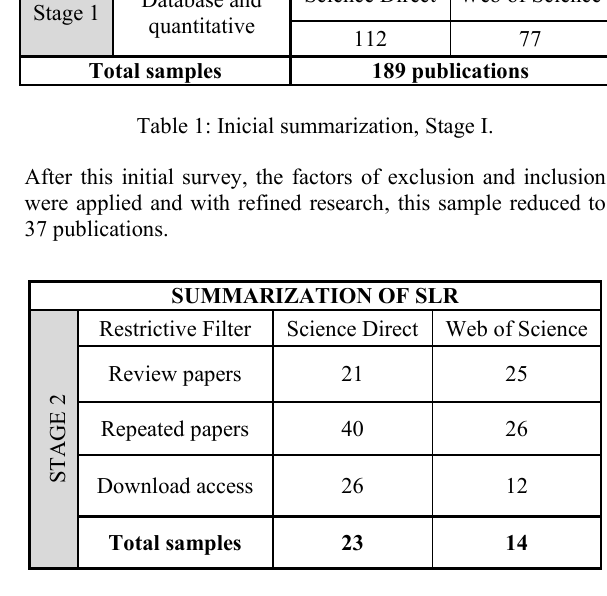
Table 2: Refined research, Stage